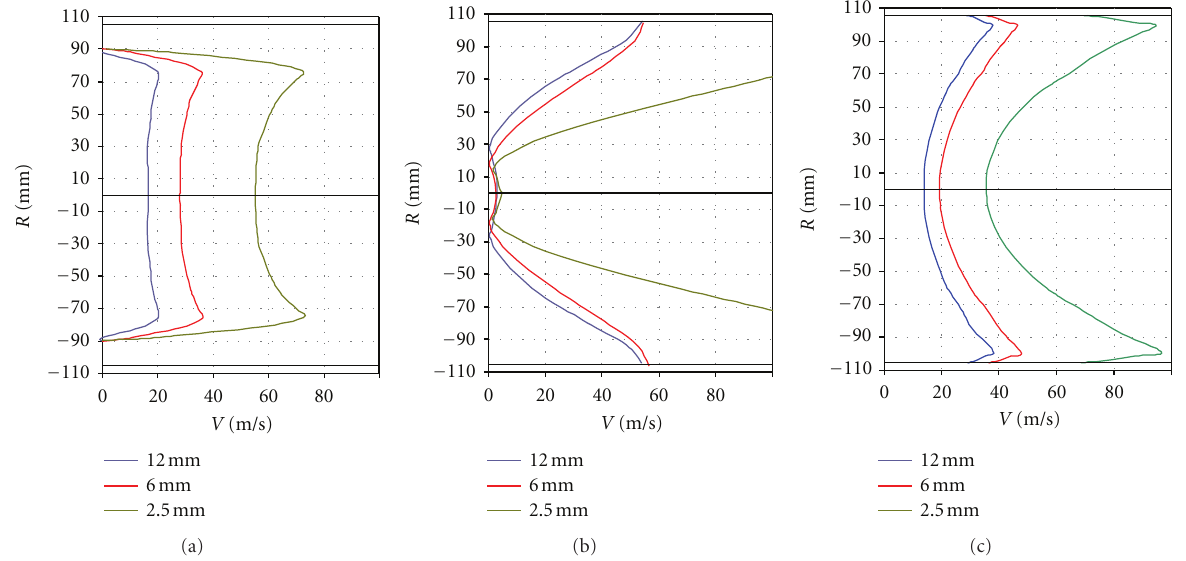
Figure 4: The velocity V. distribution in the cross-sections ( X = 2mm, 500mm, and 1000 mm).